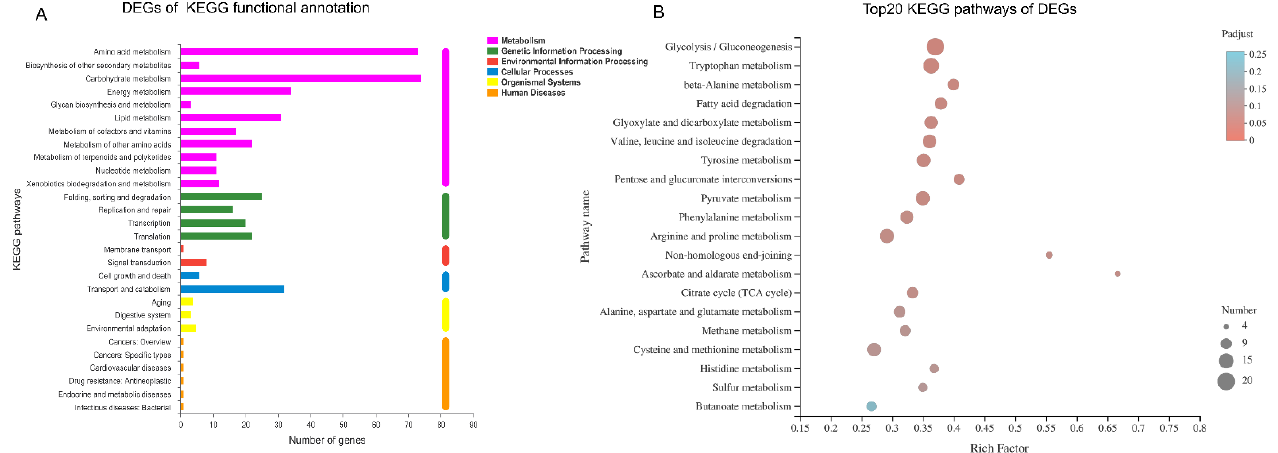
Figure 7. ( A ): KEGG functional classification of DEGs in “Con vs T11”. ( B ): KEGG pathway enrich- ment of in “Con vs T11”. The rich factor represents the number of DEGs relative to the percentage of all annotated genes involved in the pathway.